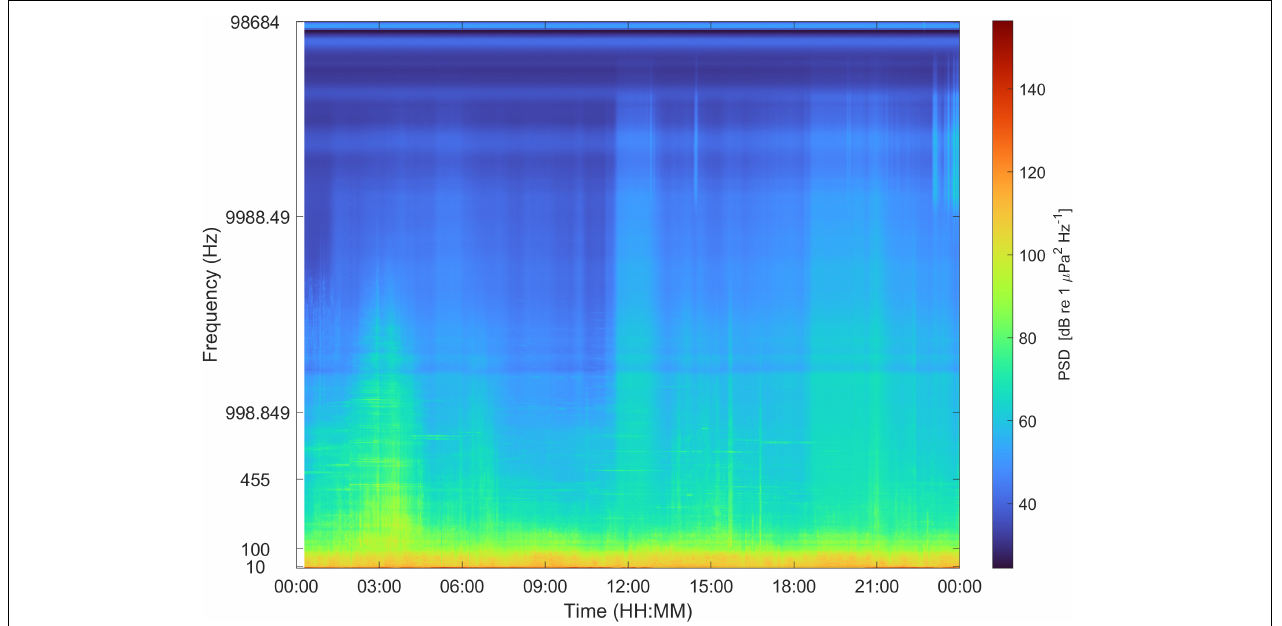
FIGURE 4 | MANTA output image of daily long term spectral average based on 1-min millidecades for January 1, 2021. This data was collected by Cornell University in the northern Gulf of Mexico. Funding for this project was provided by the U.S. Department of the Interior, Bureau of Ocean Energy Management, Environmental